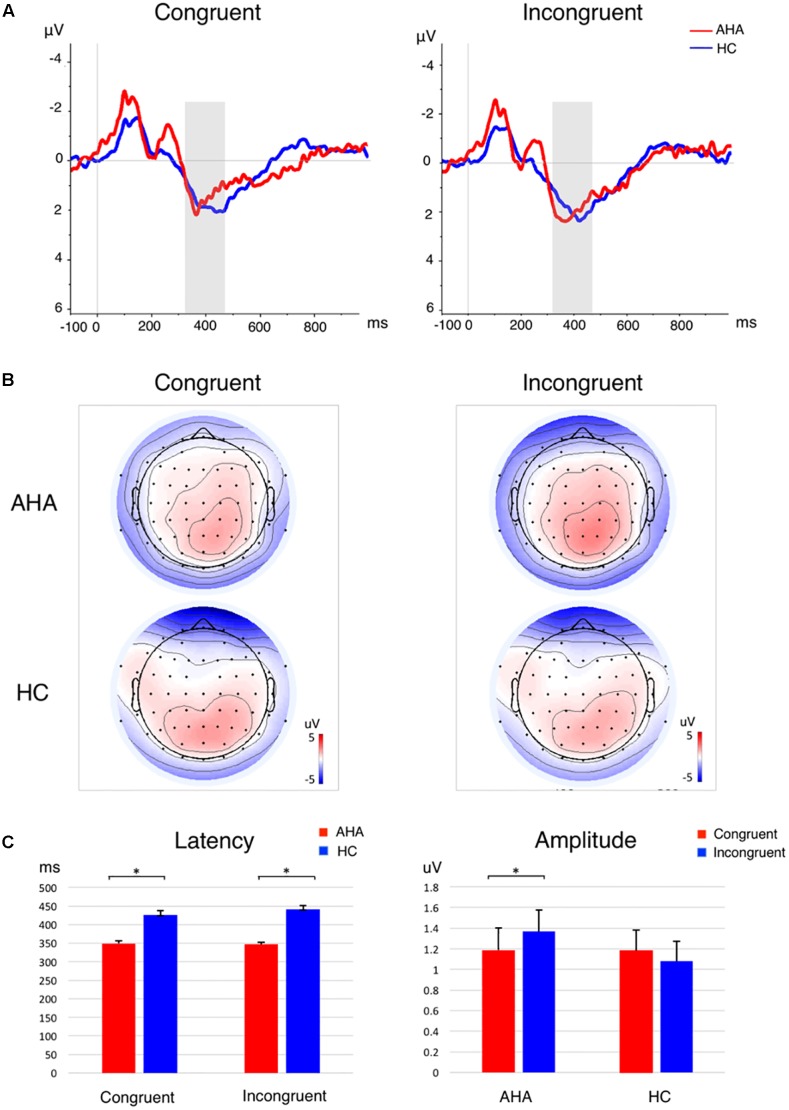
P3 component for the target-related responses. (A) The grand average ERP waveform in congruent (Left) and incongruent condition (Right). The P3 time window is marked by a gray shadow. The AHA group is depicted in red, and the HC group in blue. (B) Scalp topography of P3 component per group per condition. The P3 component is averaged across subjects and time windows. (C) Bar plots for P3 latency (Left) and amplitude (Right) per group per condition. Error bars denote standard error. ∗p < 0.05.